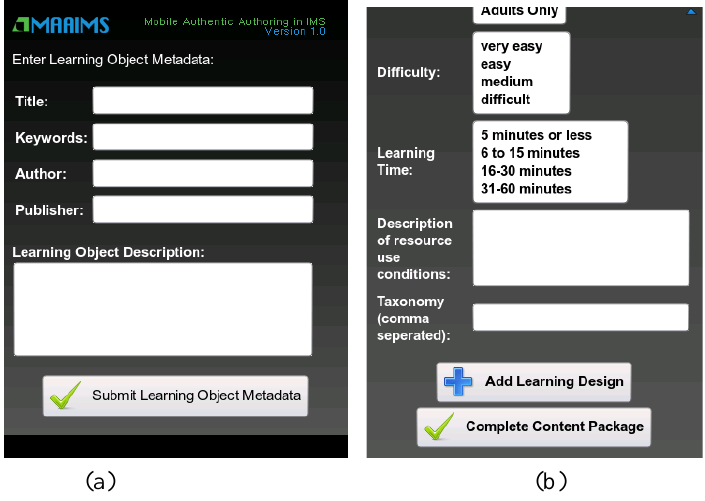
Figure 2 . RLO metadata collection in MAAIMS: (a) represents general metadata and (b) collects educational